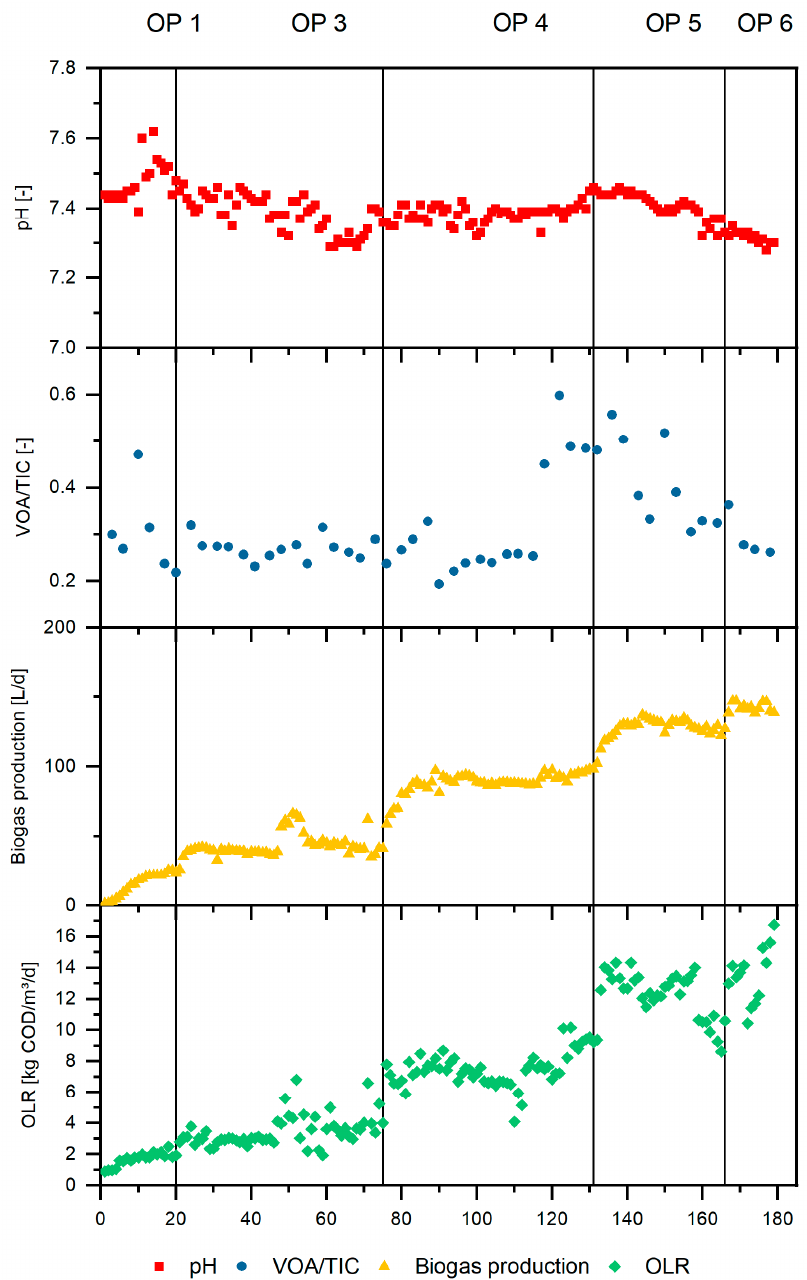
Figure 2. pH, VOA/TIC, biogas production, and COD-specific OLR of R1 over the experimental period.